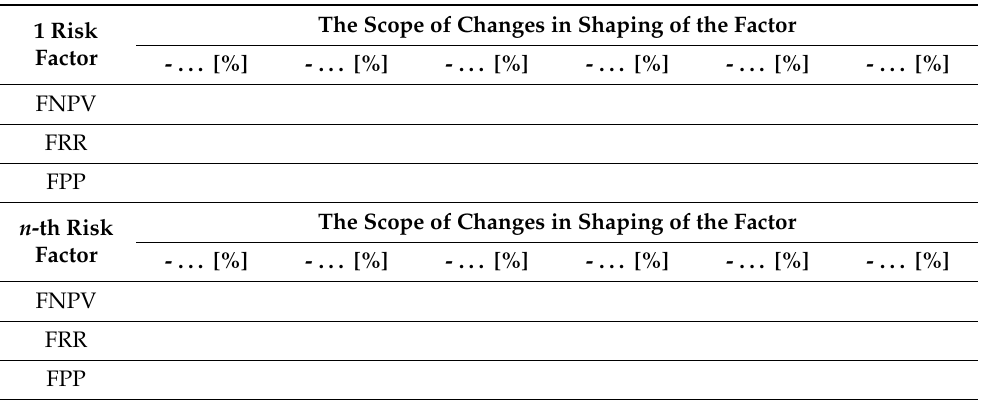
Table 8. Assessment of the financial effects of the project, taking into account changes in the shaping of risk factors. Source: designed by authors.